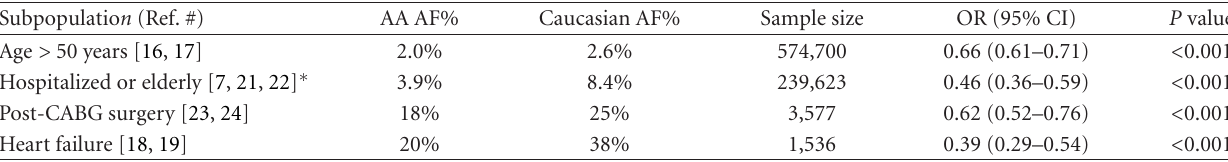
Table 4: Subpopulation analysis showing the e ff ect of African American race on prevalence of atrial fibrillation. Subpopulatio n (Ref. #)